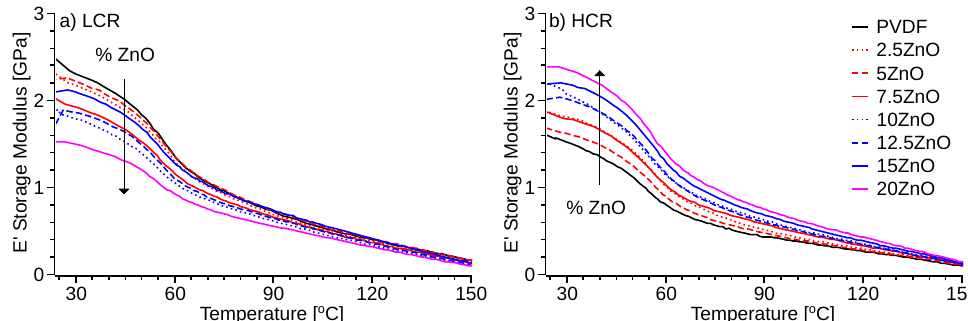
Figure 7. Storage modulus (E’) of DMA specimens 3D printed with: ( a ) low cooling rate (LCR), and ( b ) high cooling rate (HCR).